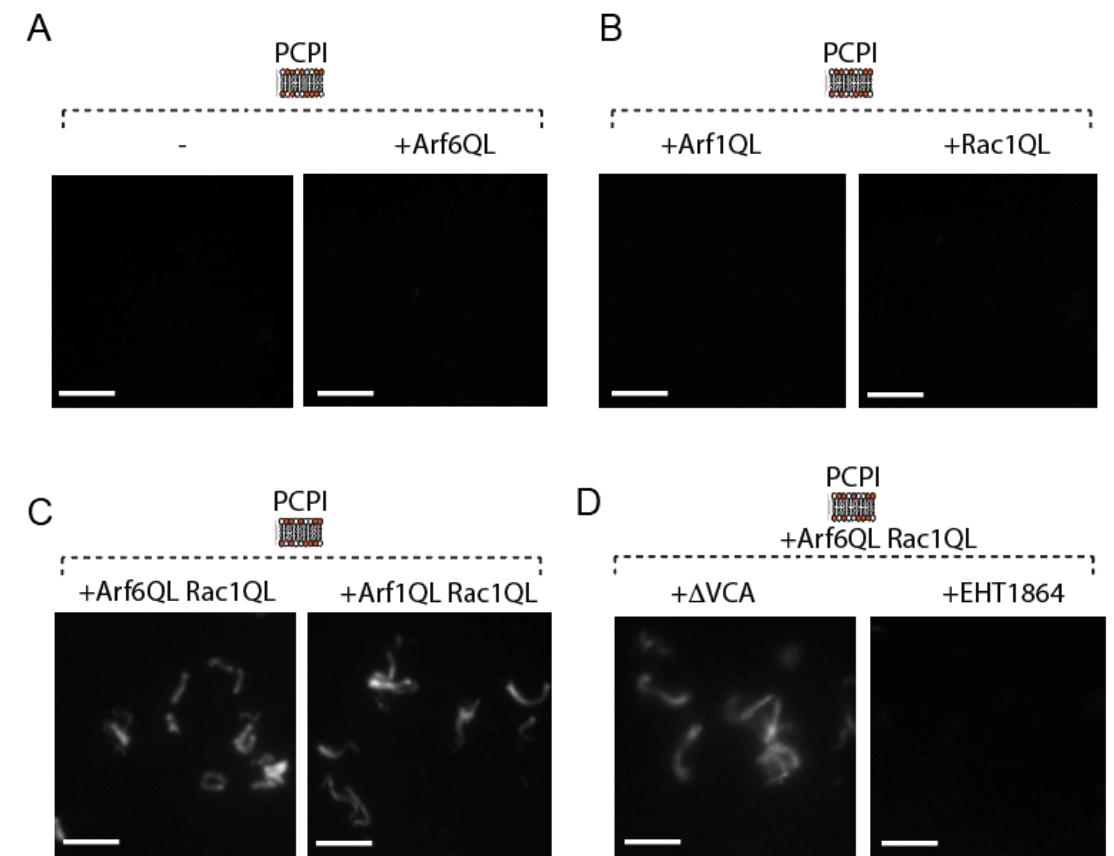
Figure 1. Fluorescence microscopy of rhodamine-actin assembly on the control, Arf6QL ( A ), Arf1QL, or Rac1QL ( B ) anchored PCPI membrane platforms in extract. ( C ) Fluorescence microscopy of rhodamine-actin assembly on Arf6QL:Rac1QL or Arf1QL:Rac1QL anchored PCPI membrane platforms in extract. ( D ) Rhodamine-actin assembly on Arf6QL: Rac1QL anchored PCPI membrane platforms in extract containing an inhibitor of Rac1 (EHT 1864) or N-WASP (n-wasp ∆ vca) (scale bars: 10 µm).